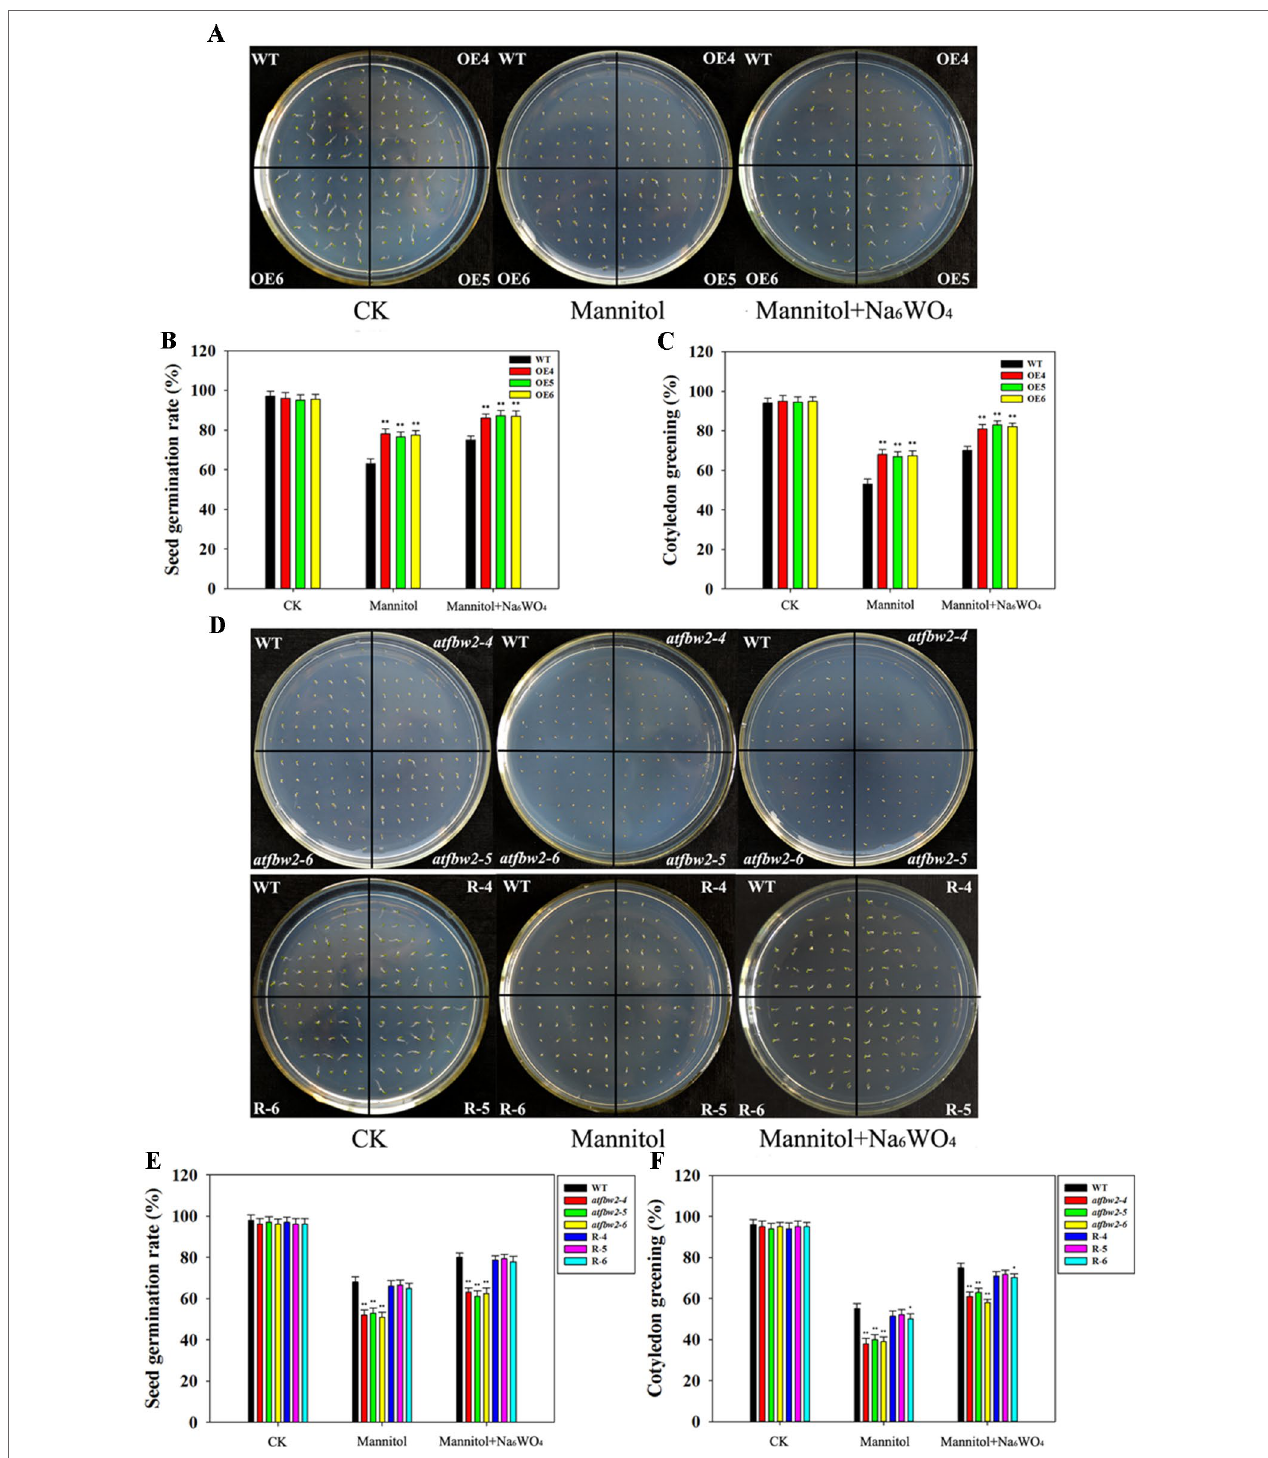
FIGURE 2 | Germination and cotyledon greening rates of Arabidopsis plants under mannitol and mannitol + Na 6 WO 4 conditions. (A) Germination phenotype, (B) germination rates, and (C) cotyledon greening rates of TaFBA1 overexpressing lines (OE4, OE5, OE6) and WT plants. (D) Germination phenotype, (E) germination rates, and (F) cotyledon greening rates of WT, mutant ( atfbw2-4 , atfbw2-5 , atfbw2-6 ) and recovery lines (R-4, R-5, R-6). Germination rates were measured 4 days after sowing, cotyledon greening rates were measured at 7 days post-sowing. Data represent the mean ± SE of three biological replicates. * P < 0.05; ** P <